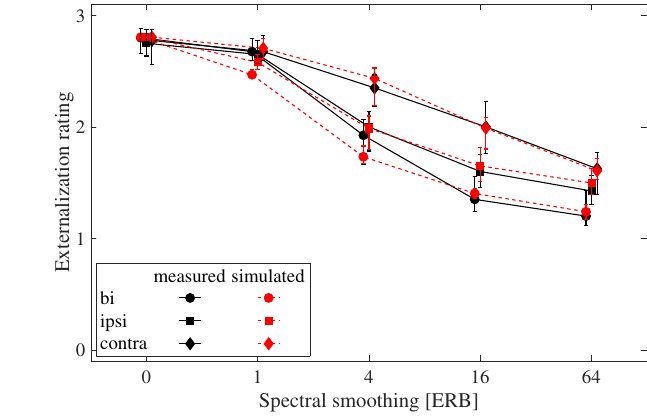
Figure 6. Median values of externalization ratings and pre- dicted results by reducing spectral details in HRTFs of both ears (condition “ bi ” ), the ipsilateral ear (condition “ ipsi ” ) or the contralateral ear (condition “ contra ” ). All other conventions are as in Figure